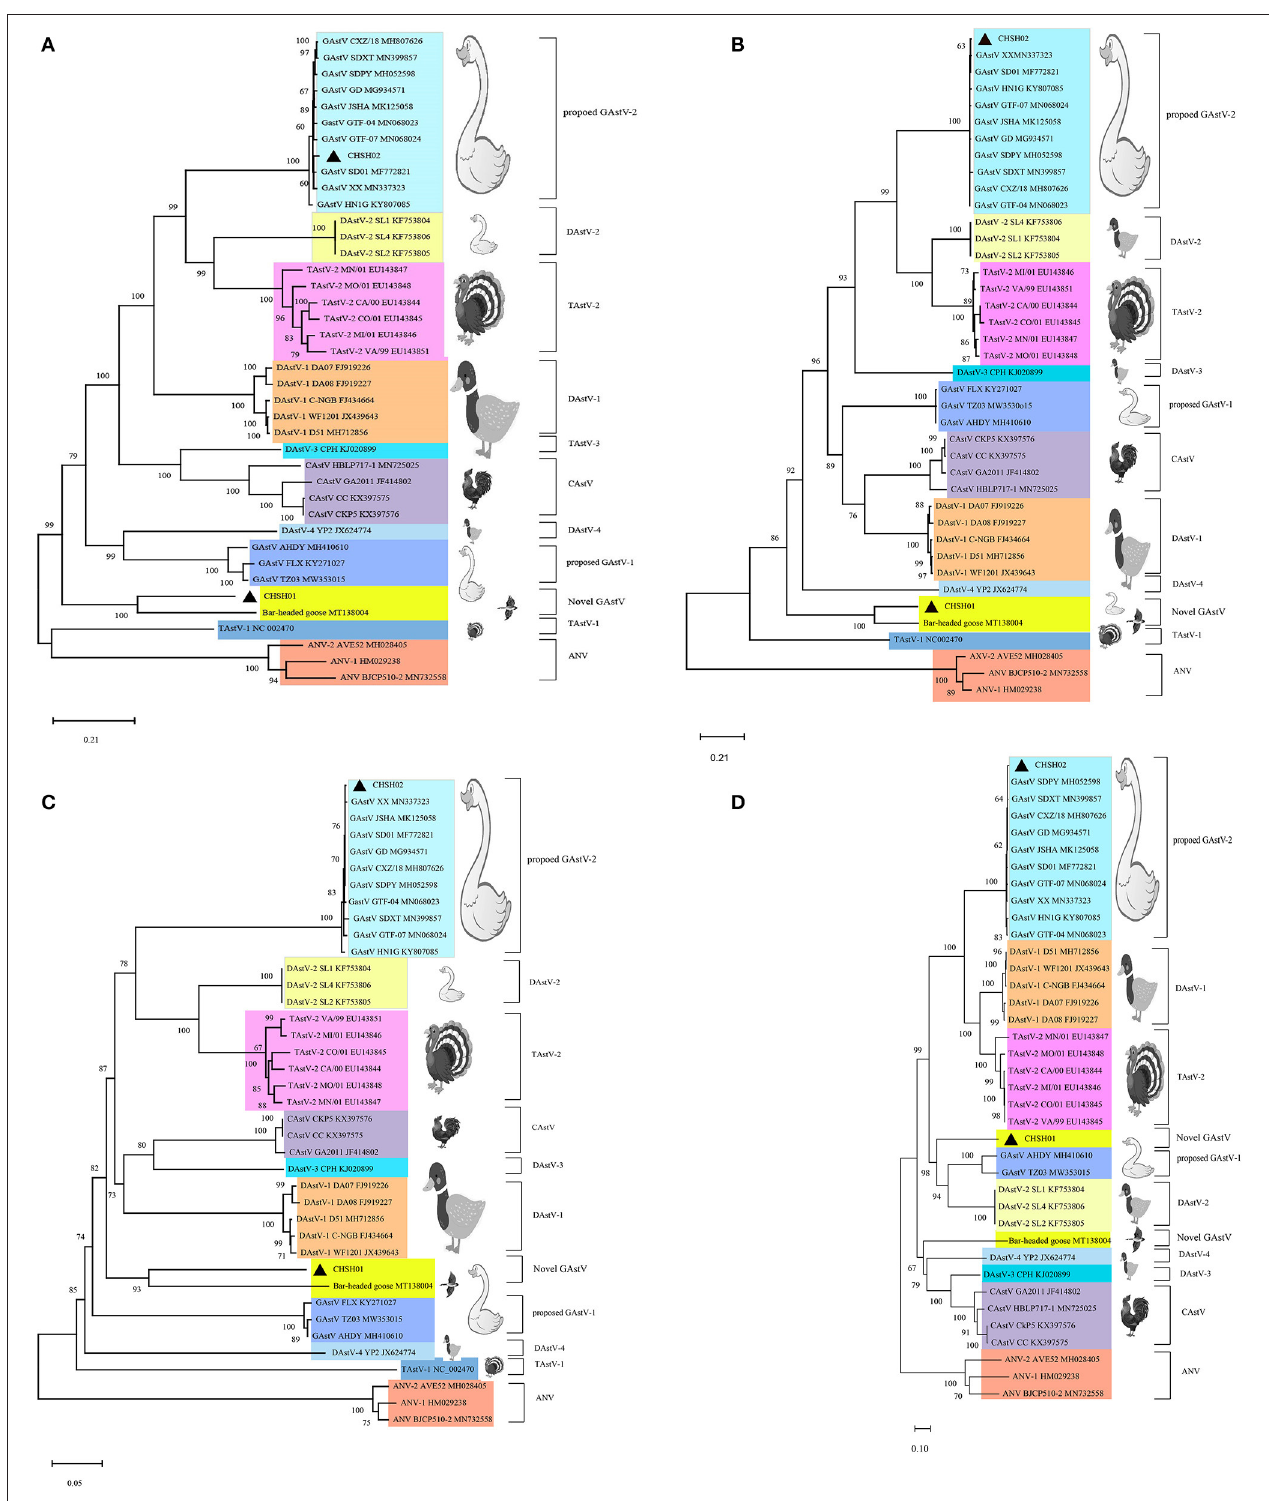
FIGURE 3 | Phylogenetic analysis of goose astrovirus. The phylogenetic trees based on whole genome sequences nt (A) , ORF1a aa (B) , ORF1b aa (C) , and ORF2 aa (D) , were constructed using the neighbor-joining method with 1,000 bootstrap replicates and the maximum composite likelihood model. The two isolates determined in this work are marked with a black